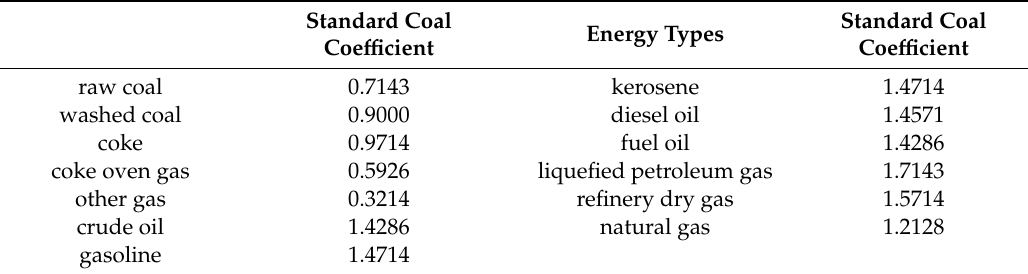
Table 1. Standard coal coe ffi cient for 13 energy